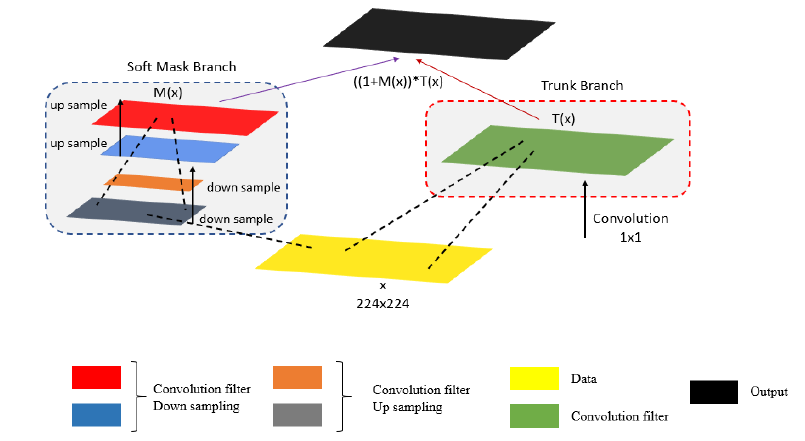
Figure 2. Proposed technical